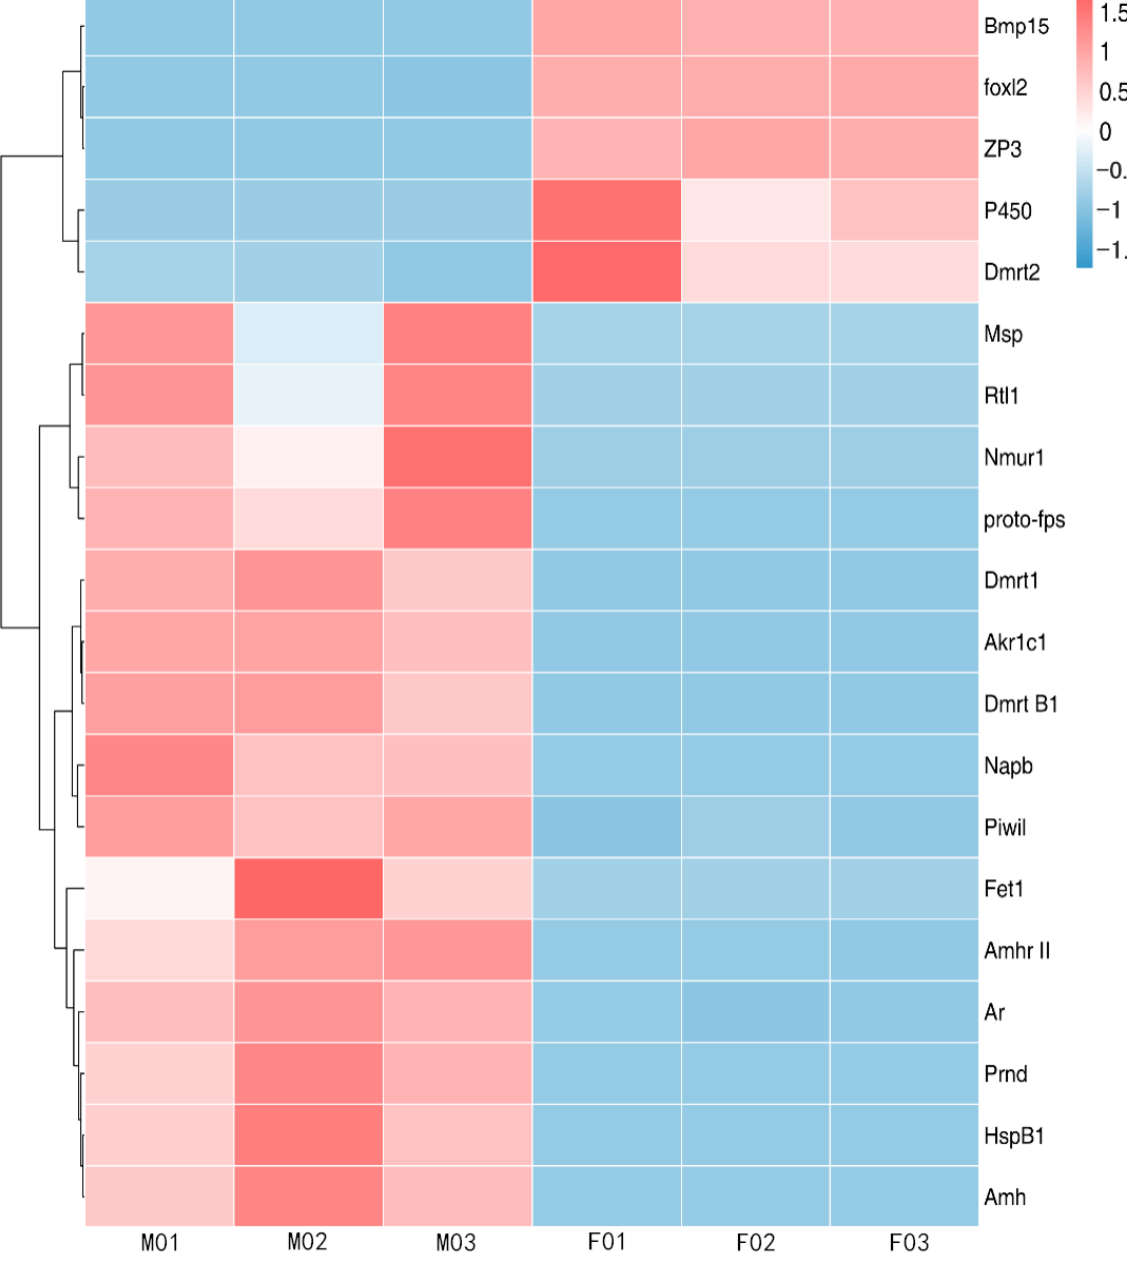
Figure 4. Heatmap of 20 typical DEGs in the gonadal tissues of male (M01–03) and female (F01–03) Andrias davidianus .